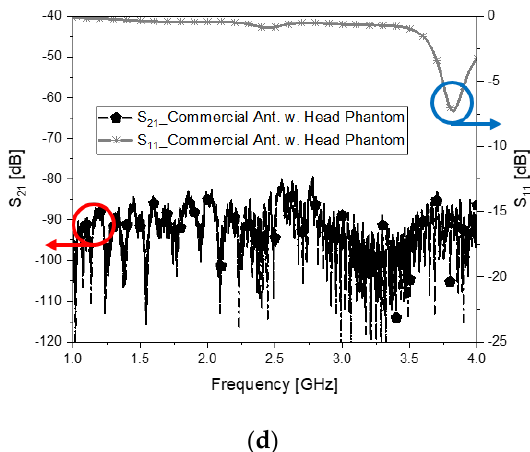
Figure 7. Antennas in the earphones and link test with the head phantom. ( a ) Cross-head link of the proposed antennas; ( b ) s-parameter of the proposed antennas; ( c ) cross-head link of the commercial antennas; ( d ) s-parameter of the commercial antennas.